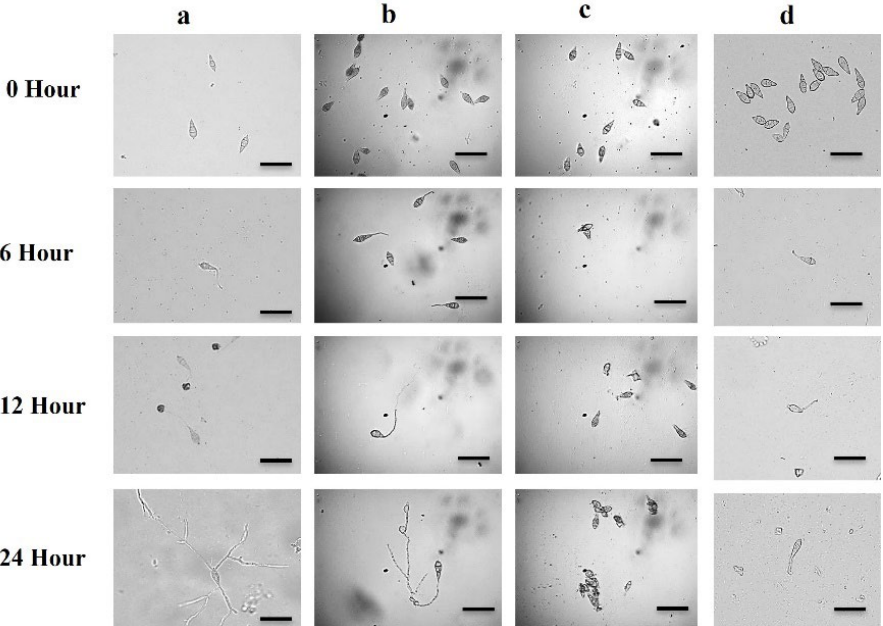
Figure 4. Micrographs showing the changes in germination and developmental transitions of MoT conidia with time-course in the untreated control (panel ( a )) and the presence of bonactin (panel ( b )), feigrisolide C (panel ( c )), and a commercial fungicide Nativo ® WG75 (panel ( d )) at 0.5 µg/mL. Bar = 10 µm.